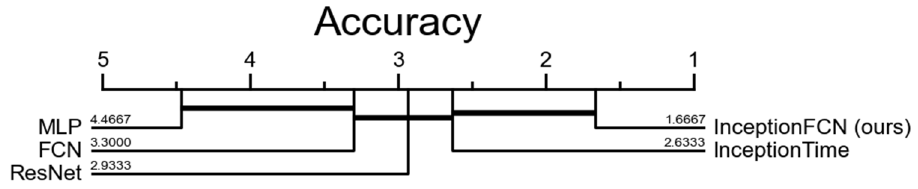
Figure 3. Critical difference diagram of the arithmetic means of the ranks for the selected DL meth- ods .